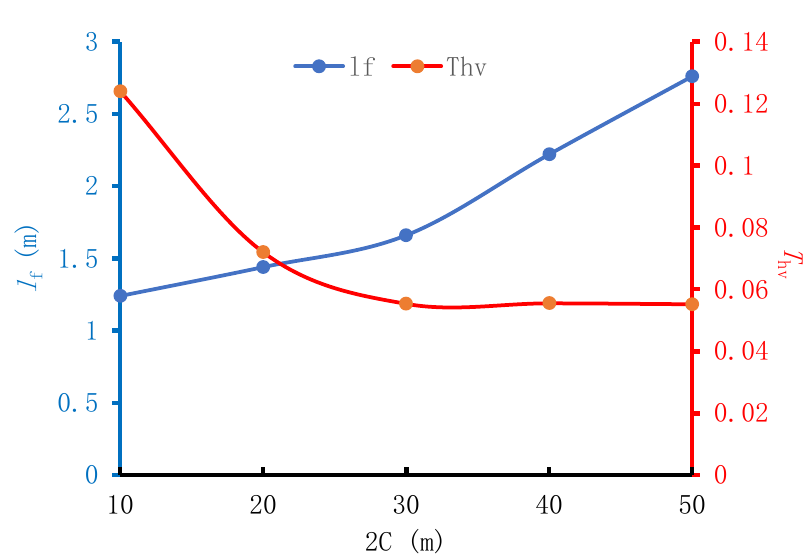
Figure 7. The length of horizontal fracture and the shape of T-type fracture change with the height of vertical fracture.